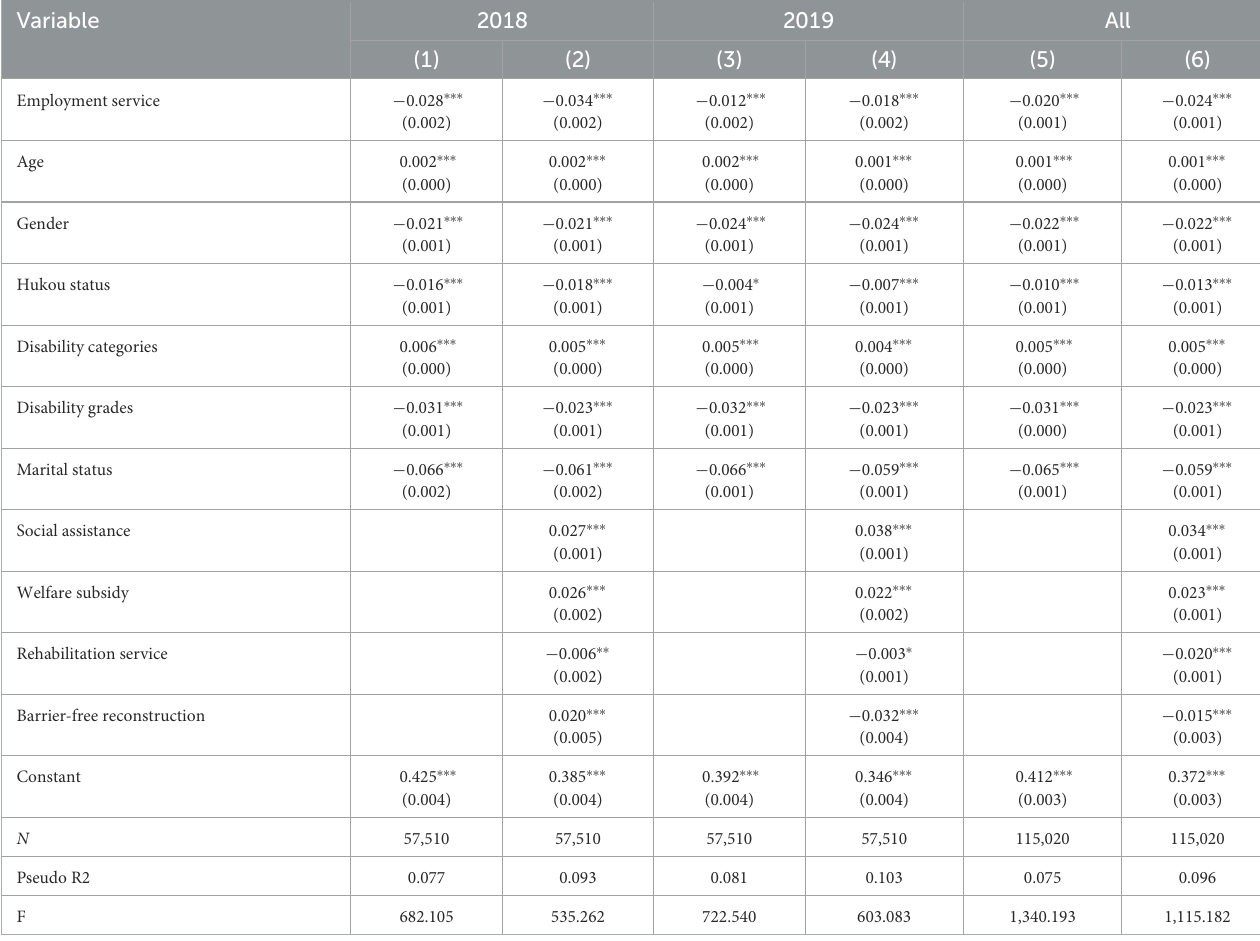
TABLE 7 Effect of employment services on MPI: OLS estimate